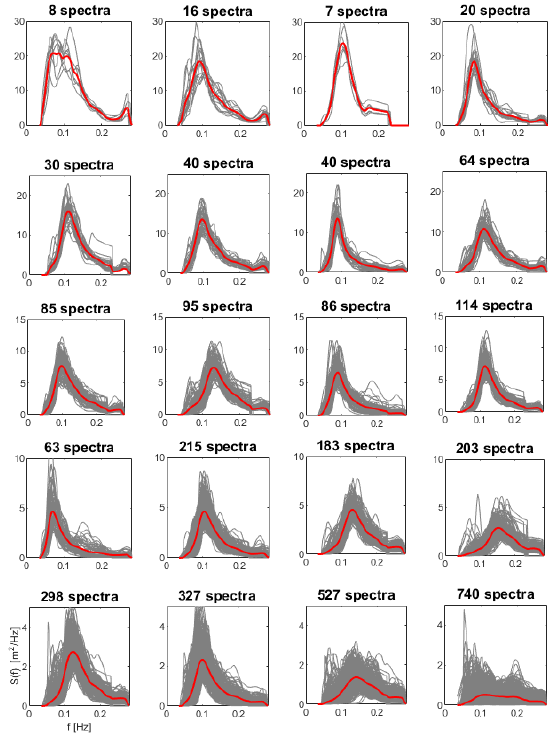
Fig. 6. Each group’s wave spectra and their representative sea states in S(f) space, title represents the number of each group’s members for method